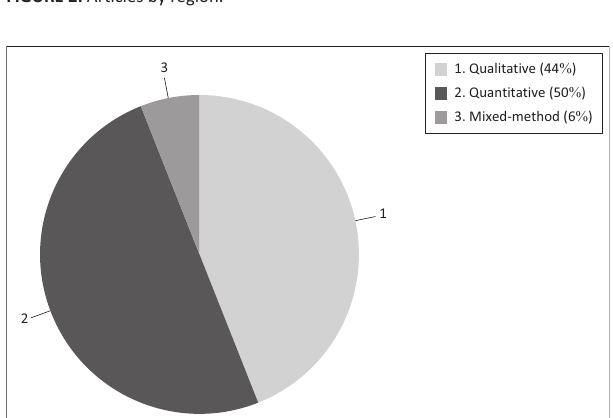
FIGURE 2: Articles by region.